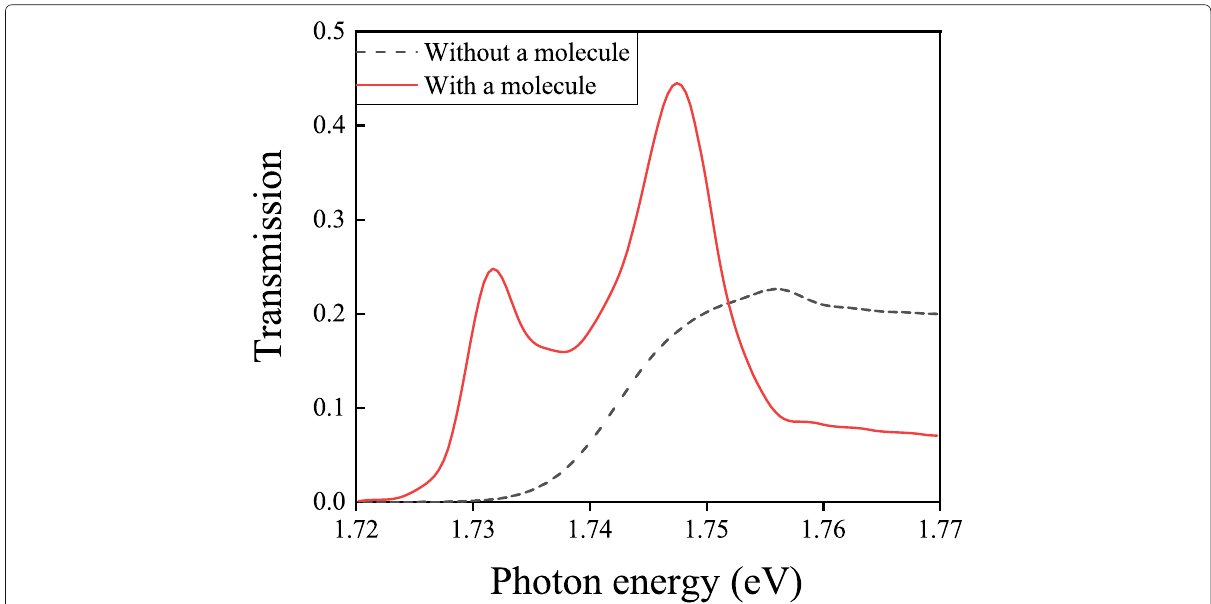
Fig. 6 Transmission spectra with and without a molecule is trapped at point